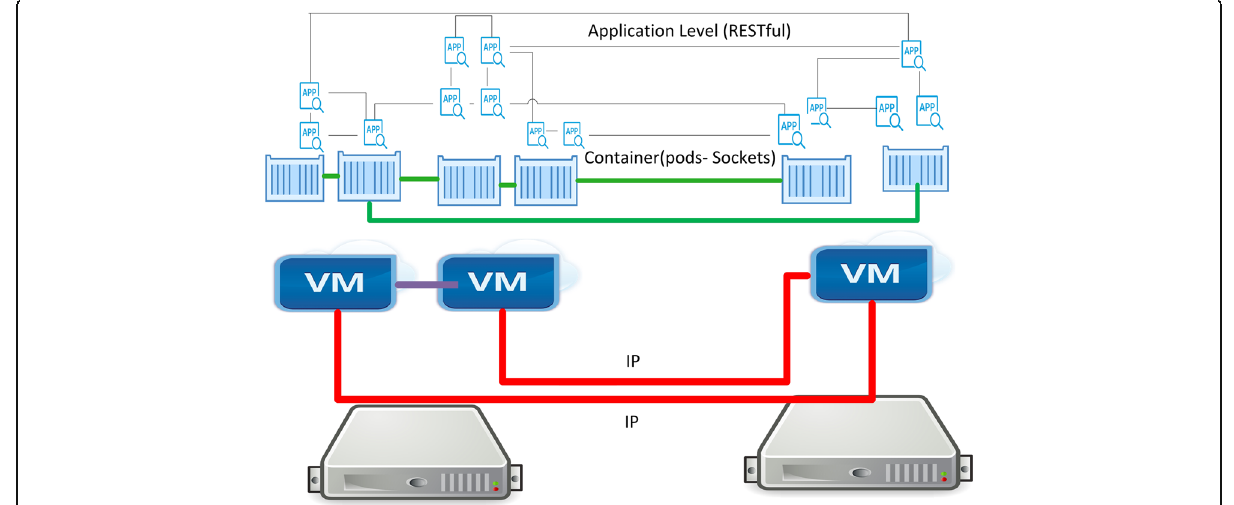
Fig. 14 Communication demand models in different